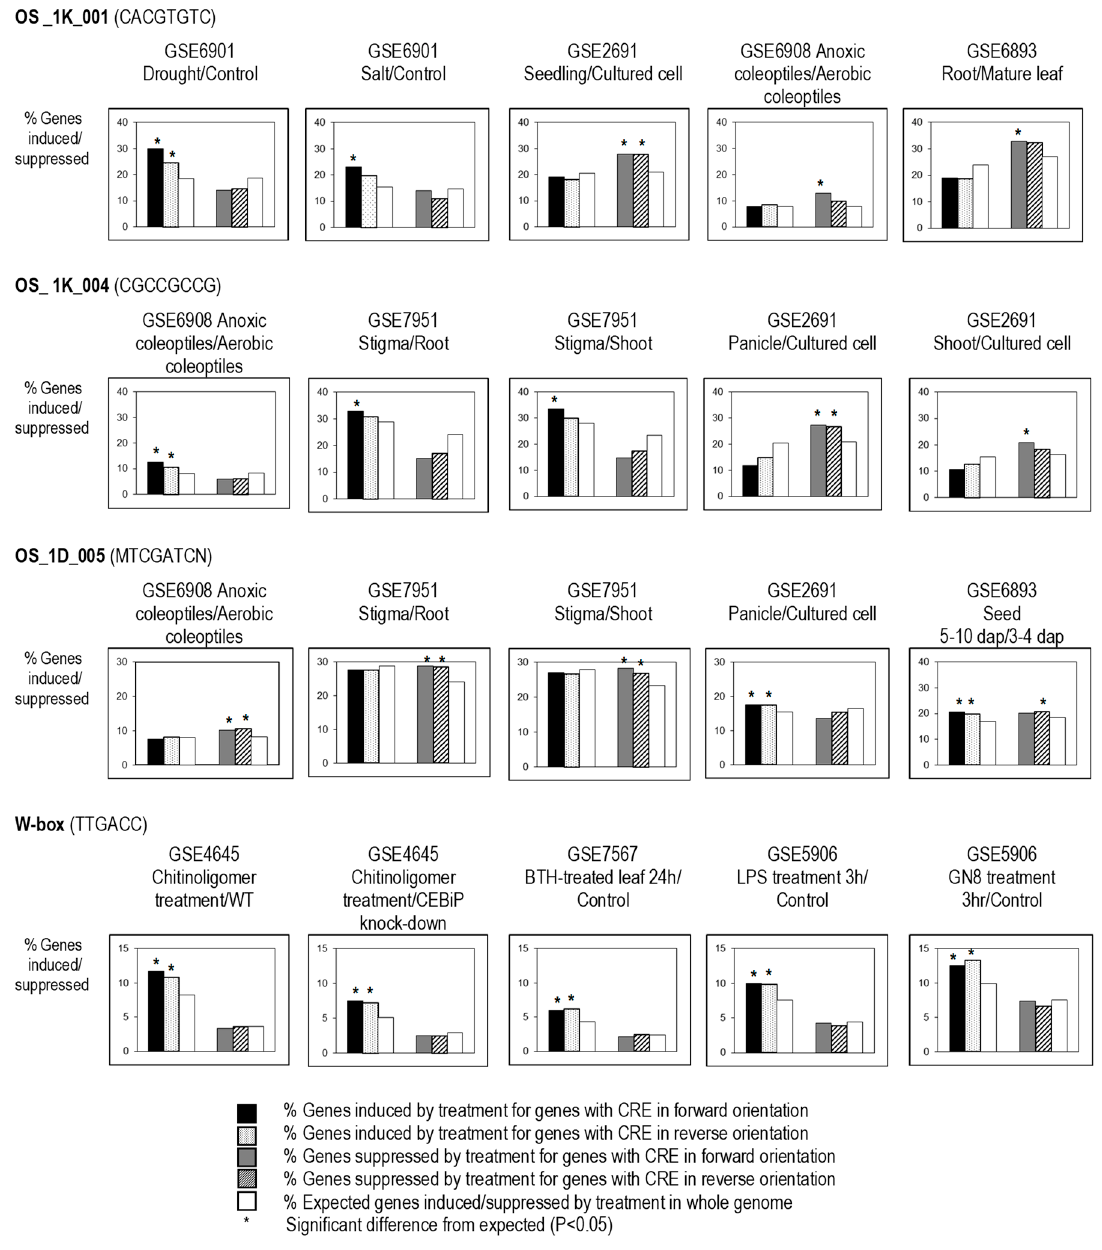
Figure 3. Orientation requirement for the effectiveness of CREs. Genes with non-palindromic CREs in either forward (on the sense strand) or reverse (antisense) orientation in the 1-kb upstream sequence from the transcription start site were tested: where the population of genes with the element is significantly (*; P-value < 0.05) more induced or suppressed than expected in both orientations, the element is considered to be bidirectional; where only one orientation of CRE shows significantly different expression than expected, then it is considered orientation-sensitive or unidirectional.